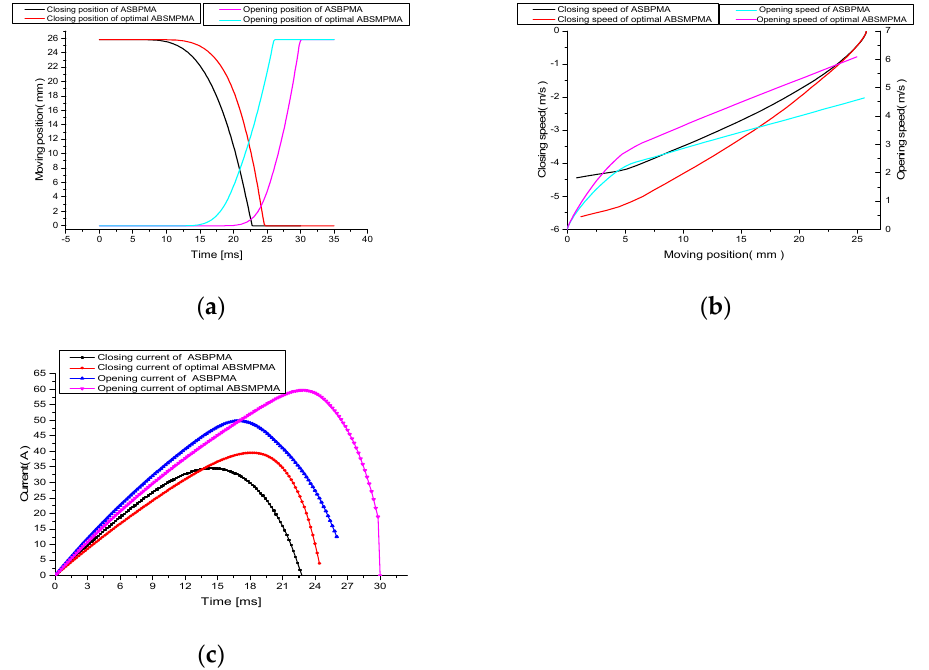
Table 3. Parameters of prototype. Design Parameter